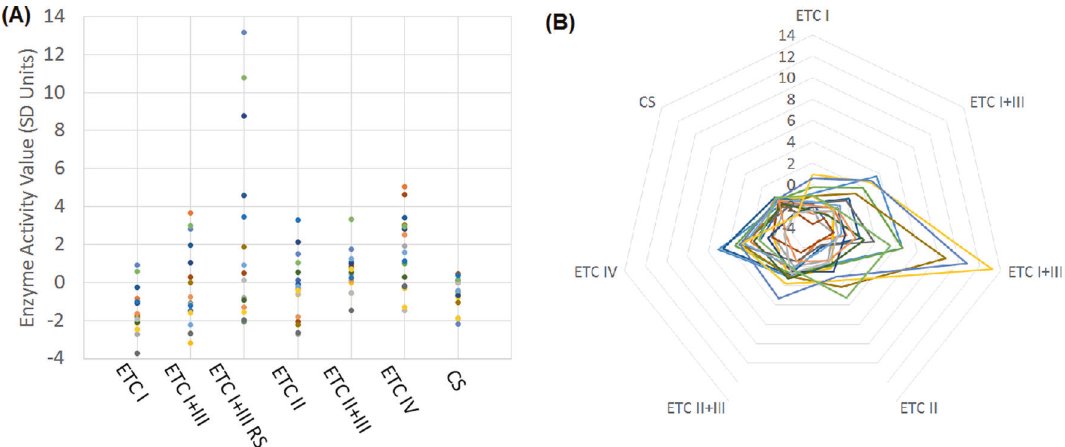
Fig. 2 Electronic transport chain activity of autism spectrum disorder fi broblast cell lines. Standardized mitochondrial enzyme activity from 18 ASD fi broblasts represented in (A) linear graph and (B) radar plot. Green box represents normative range (±1.96 SD). ETC = Electron transport chain; CS = Citrate Synthase.